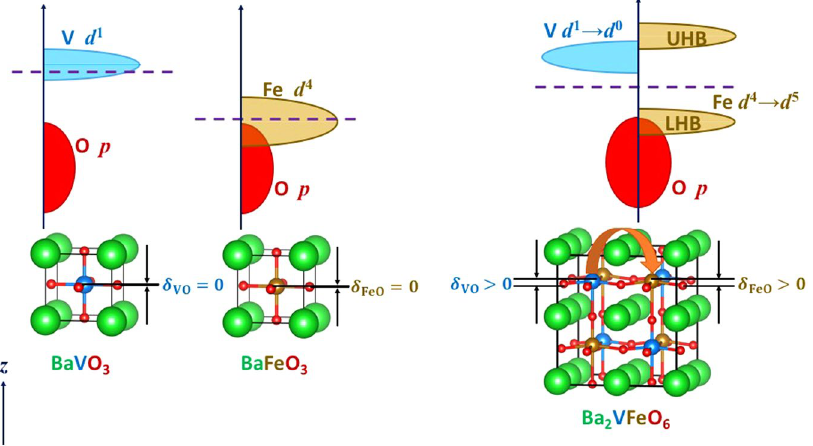
Figure 1. Design principles for charge-transfer-driven Mott multiferroics. (a) Energy diagram and atomic structure of cubic BaVO 3 . The dashed line is the Fermi level. δ VO is the V-O displacement along the [001] direction. (b) Energy diagram and atomic structure of cubic BaFeO 3 . The dashed line is the Fermi level. δ FeO is the Fe-O displacement along the [001] direction. (c) Energy diagram and atomic structure of double perovskite Ba 2 VFeO 6 . The dashed line is the Fermi level, which lies in the gap between V d and Fe d states. ‘LHB’ (‘UHB’) means lower Hubbard bands (upper Hubbard bands). The red arrow indicates the charge transfer from V atoms to Fe atoms due to electronegativity difference. In the double perovskite Ba 2 VFeO 6 , a polar distortion is developed ( δ VO > 0 and δ FeO > 0) because of the new charge configuration V d 0 and Fe d 5